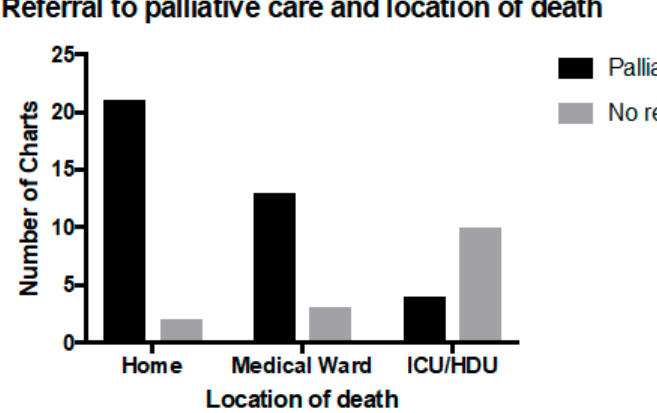
Figure 3. Location of child at time of death and referral to palliative care in 53 patients.